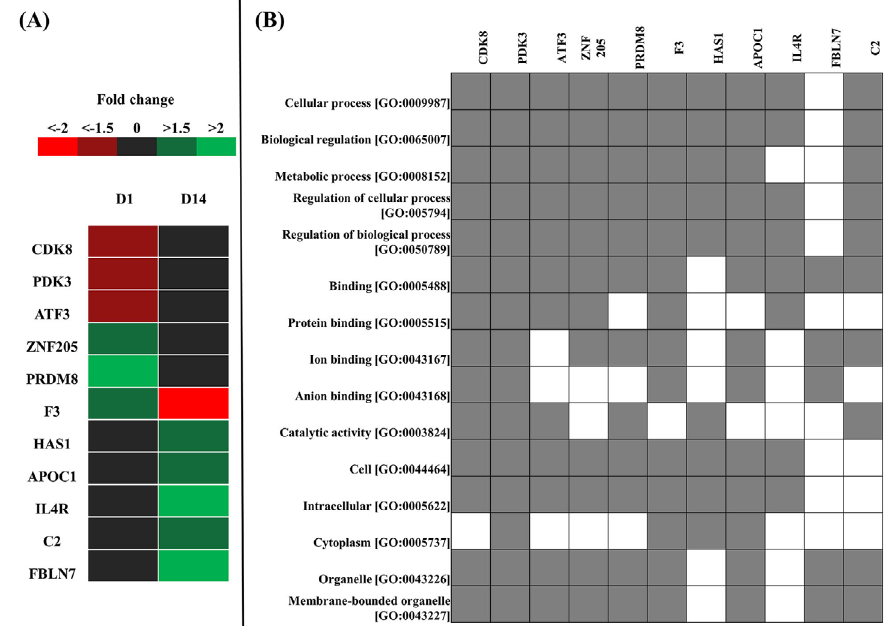
Figure 4- Mapping of selected genes. (A) Heat map of the selected genes displaying fold change. (B) Map of selected genes that were involved in the top 5 most enriched GO terms. Day 1 (D1) and Day 14 (D14)